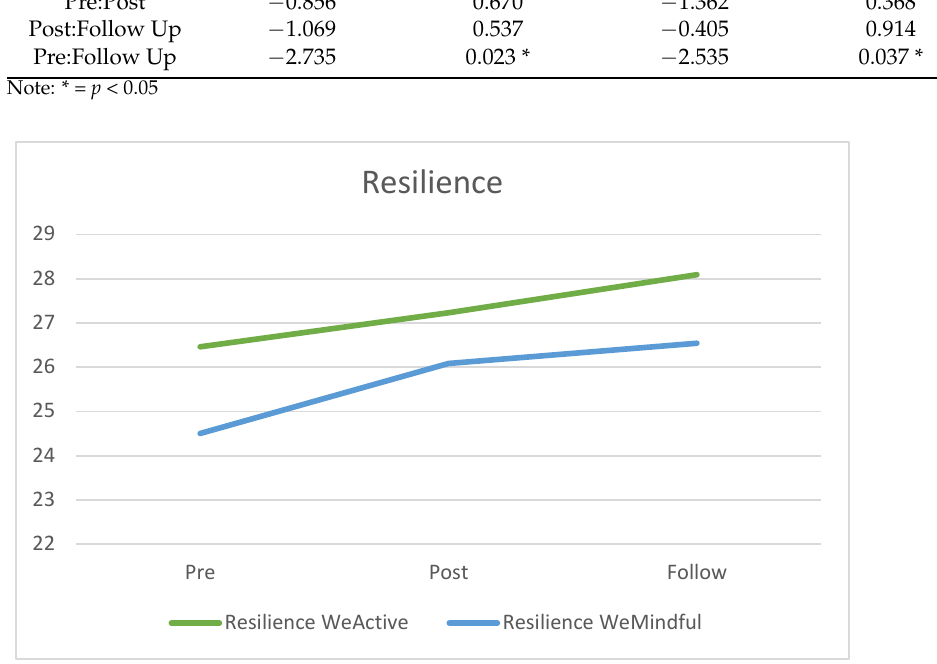
Figure 2. Average resilience scores for both groups at pre-test, post-test and follow up.